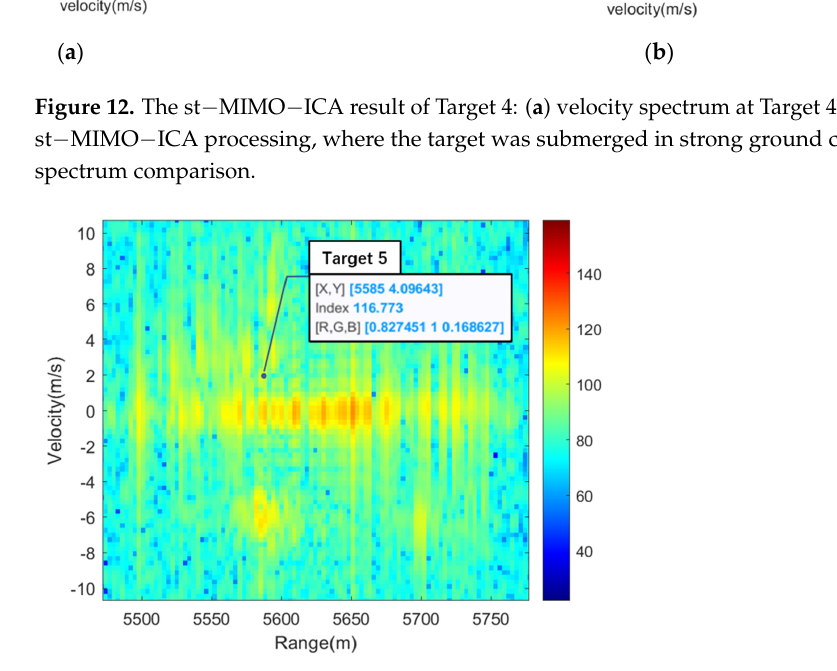
Figure 13. The range − velocity map in Channel 1 for the second field experiment. Target 5 ′ s information is indicated via a data label, and the target can be seen together with some competing ground clutter.